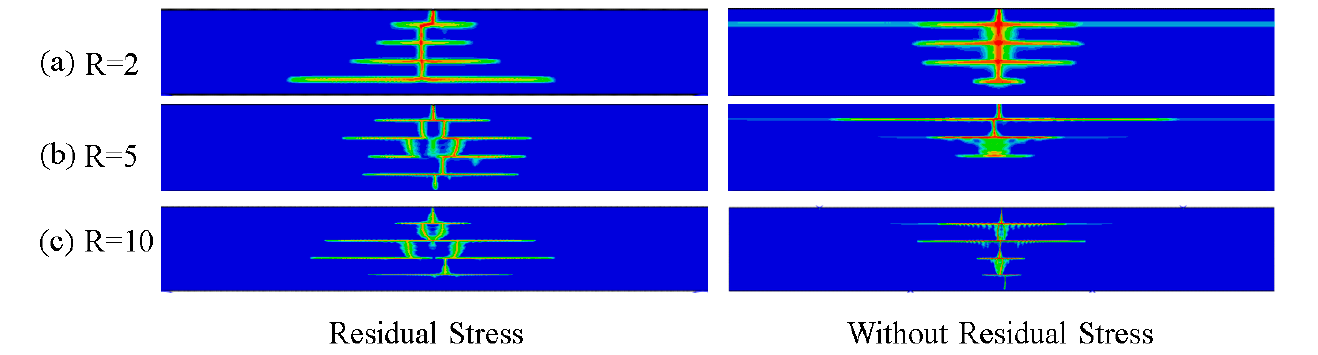
Figure 8. Force–displacement curve of the Al 2 O 3 /ZrO 2 -laminated ceramic specimen under bending.